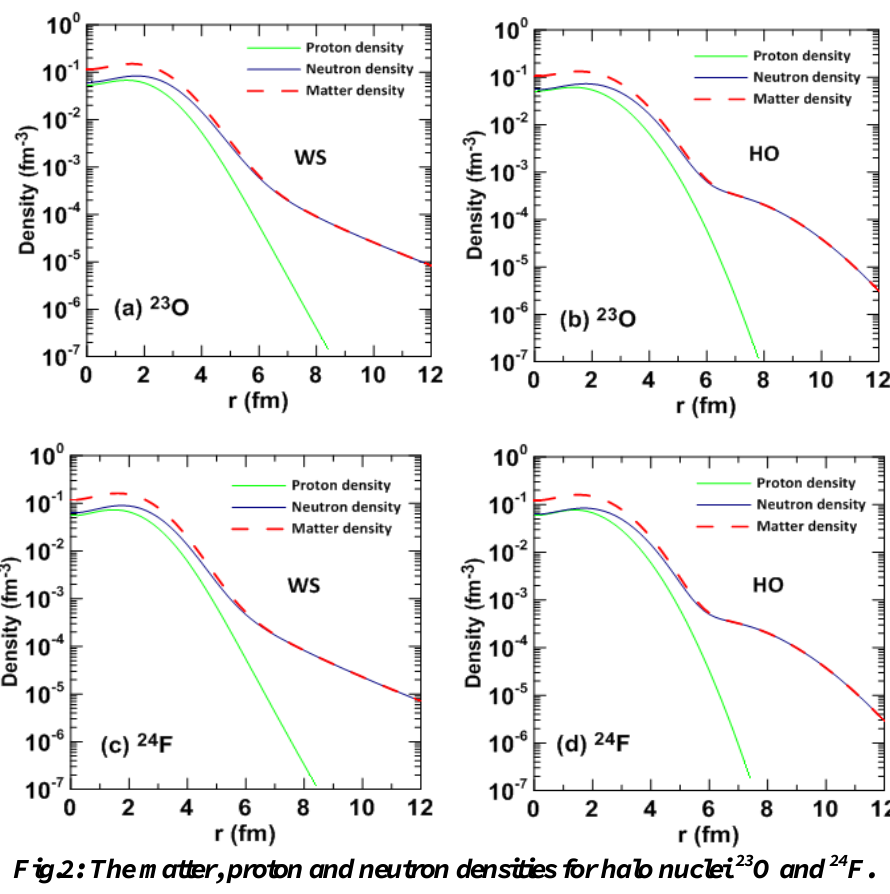
Fig.2: The matter, proton and neutron densities for halo nuclei 23 O and 24 F.